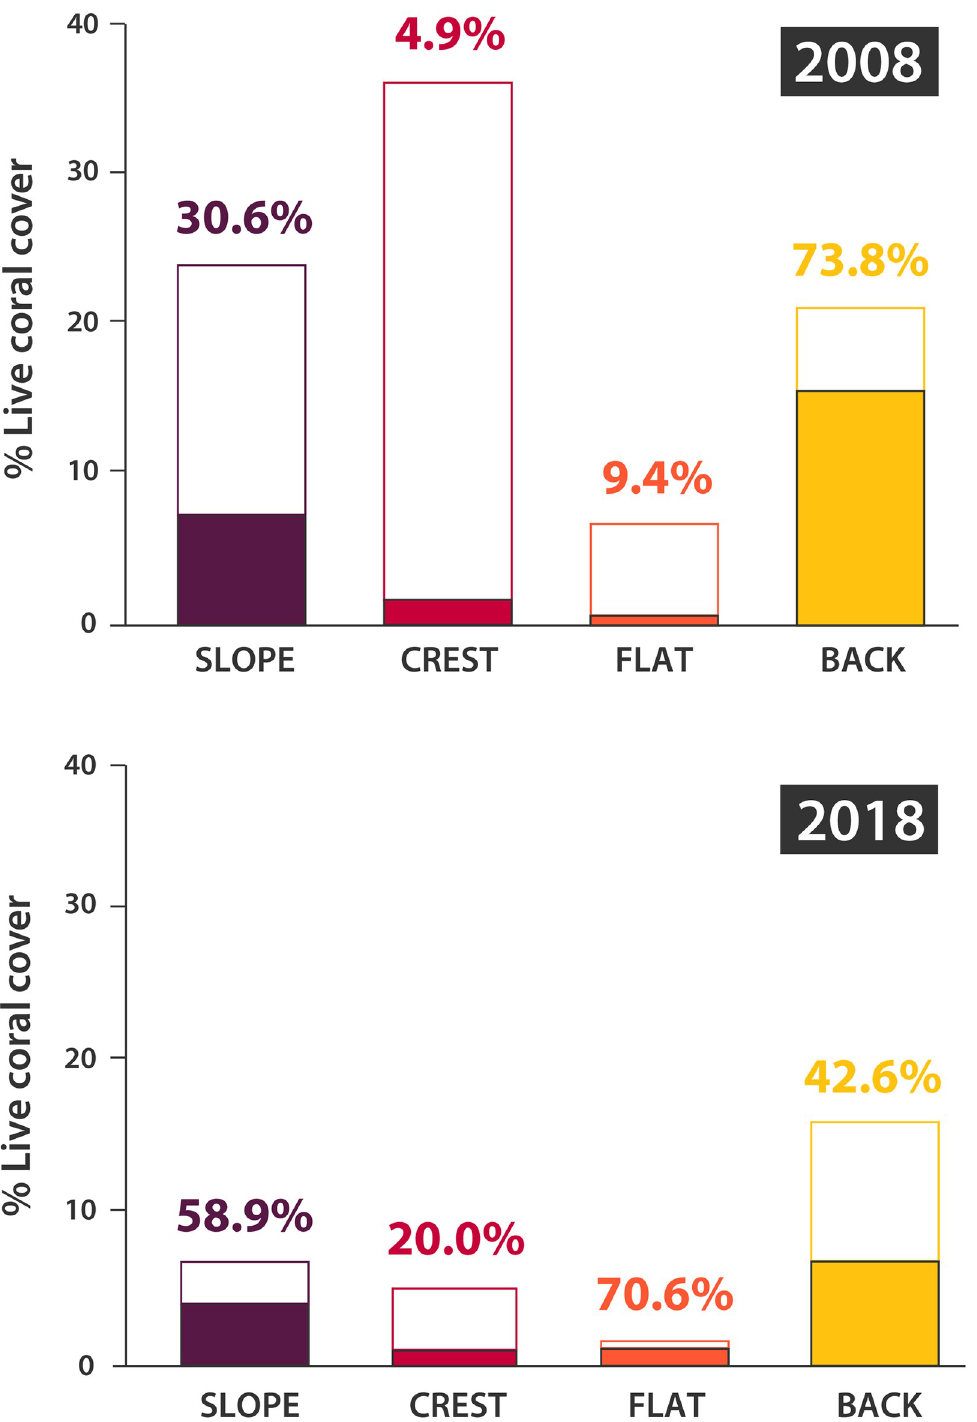
Fig 2. Changes in the benthic cover at Lizard Island, on the Great Barrier Reef. Percentage of reef substratum occupied by massive Porites (filled) and other hard corals (empty) in 2008 and 2018. Purple, red, orange, and yellow indicate the slope, crest, flat, and back reef habitats, respectively. Values above the bars indicate the percentage of massive Porites cover relative to total coral cover for the respective habitat.